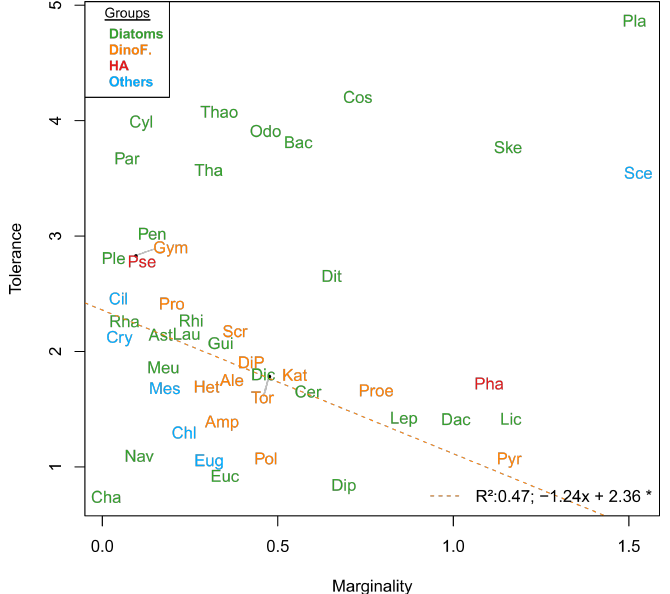
Figure 5. Biplot summarizing the relationship between the marginality (OMI parameter) and the tolerance (TOL) of the community’s realized niches. The dashed lines represent the linear regression performed over OMI and TOL values over all taxa (black), the diatoms (green), and the dinoflagellates (orange). The * in the legend shows the significance of the linear regression ( p <